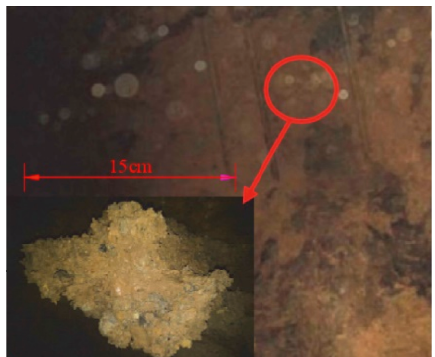
Figure 2: Soft plastic red clay.